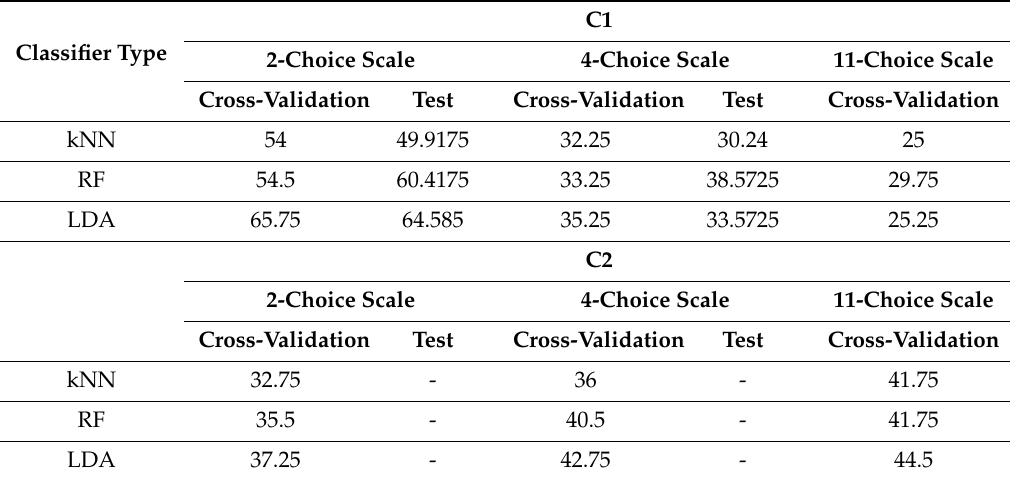
Maximum cross-validation accuracy and test (validation) accuracy (in %) for the player-independent modality, with SFS feature selection.